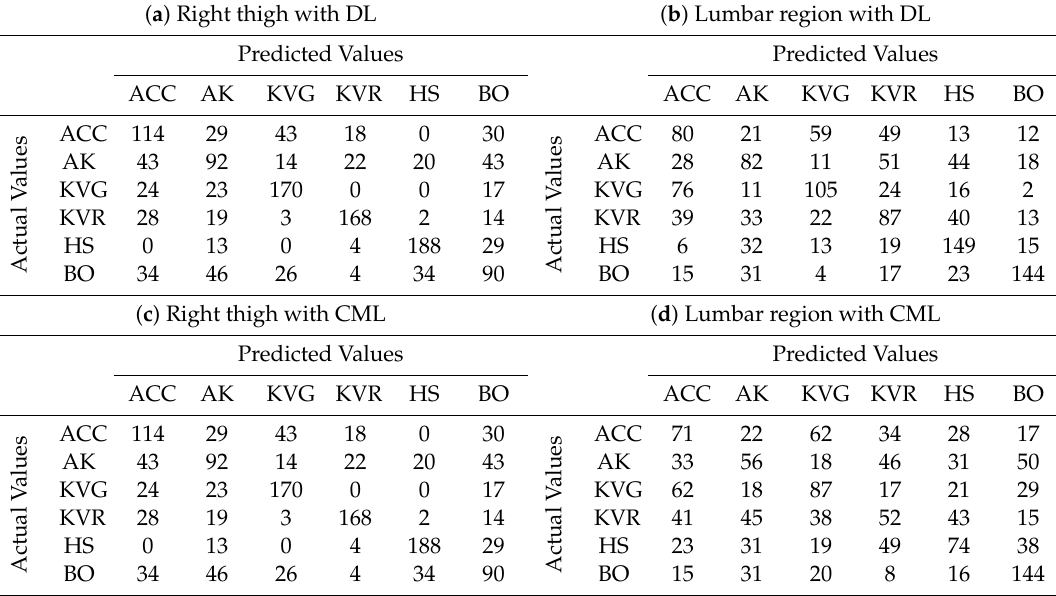
Table 3. Confusion matrix for ( a ) right thigh and ( b ) lumbar region when squats were classified using a single IMU with DL, and confusion matrix for ( c ) right thigh and ( d ) lumbar region when squats were classified using a single IMU with CML. The predicted class refers to the classification provided by an expert, whereas the actual class refers to the classification provided by the mean values of the class in which the subject actually operates.